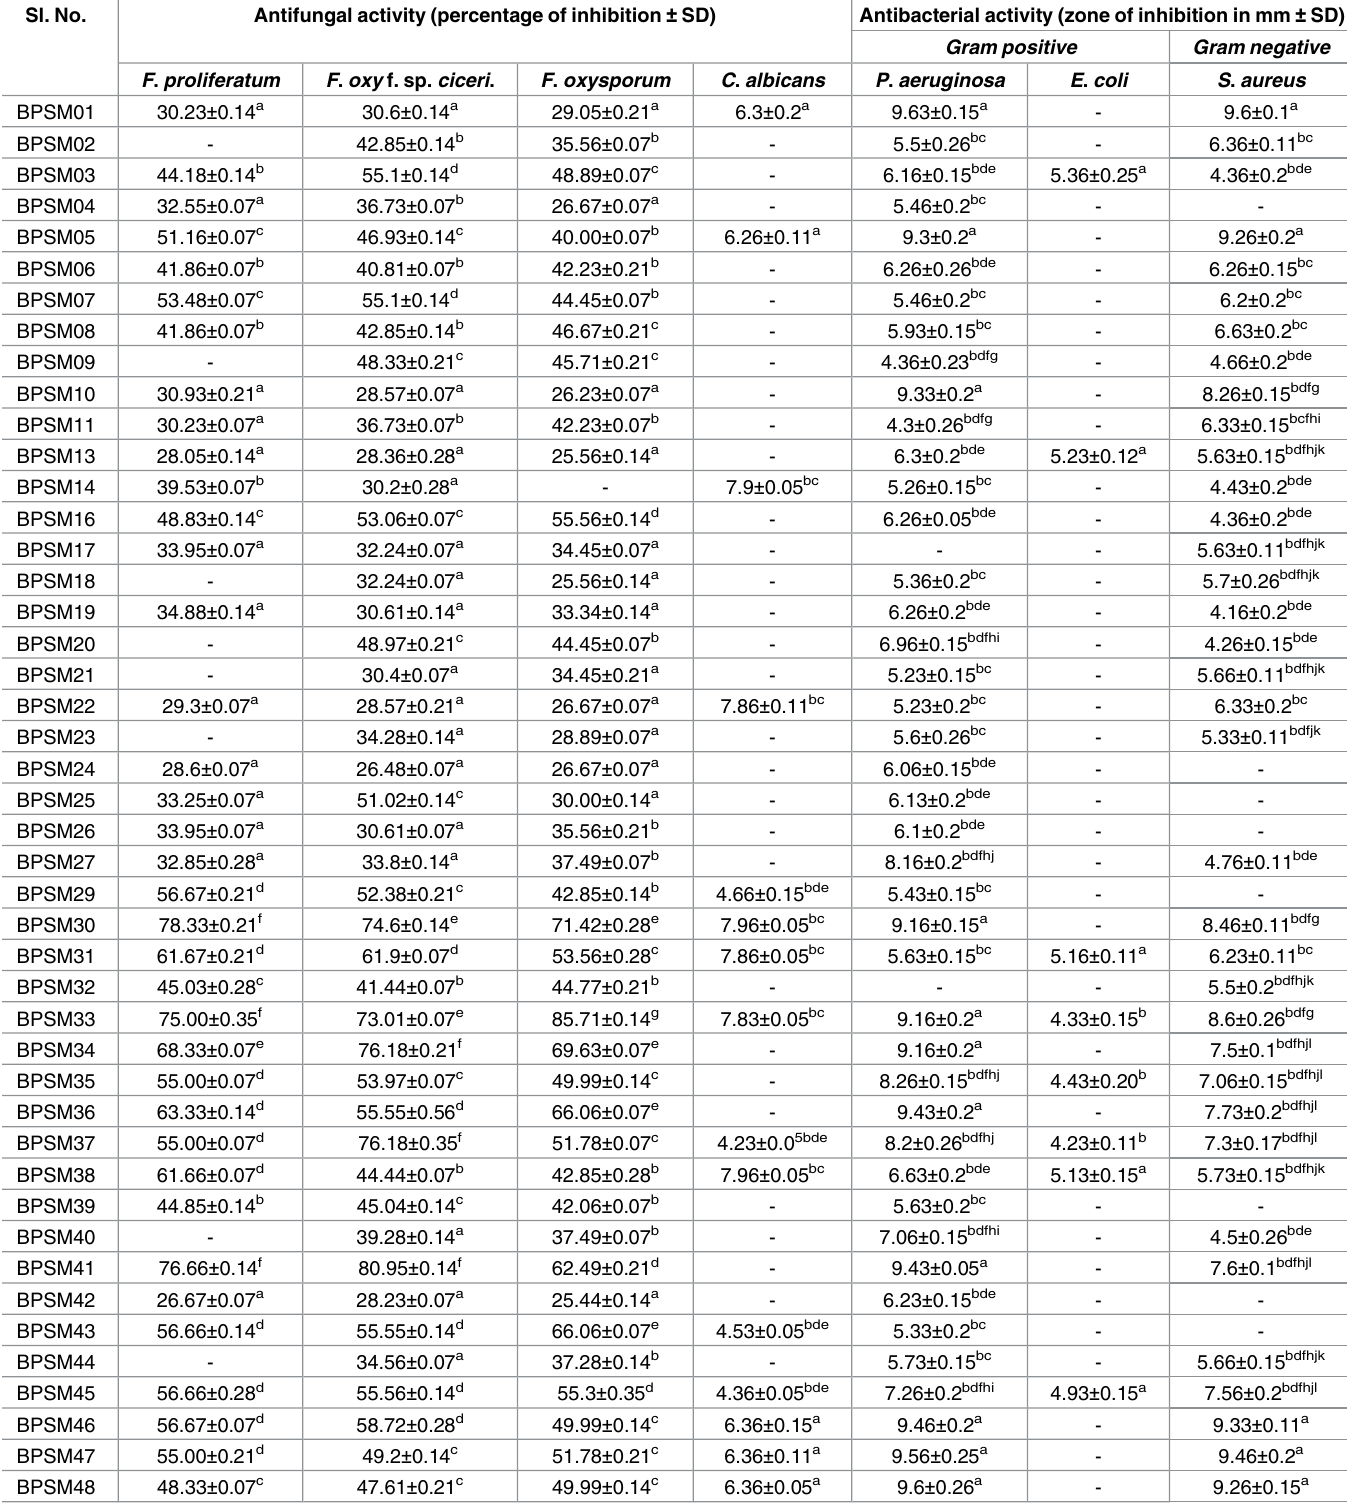
Table 2. Antimicrobial activity of wild mushrooms against selectedbacterial and fungal pathogens. Sl.